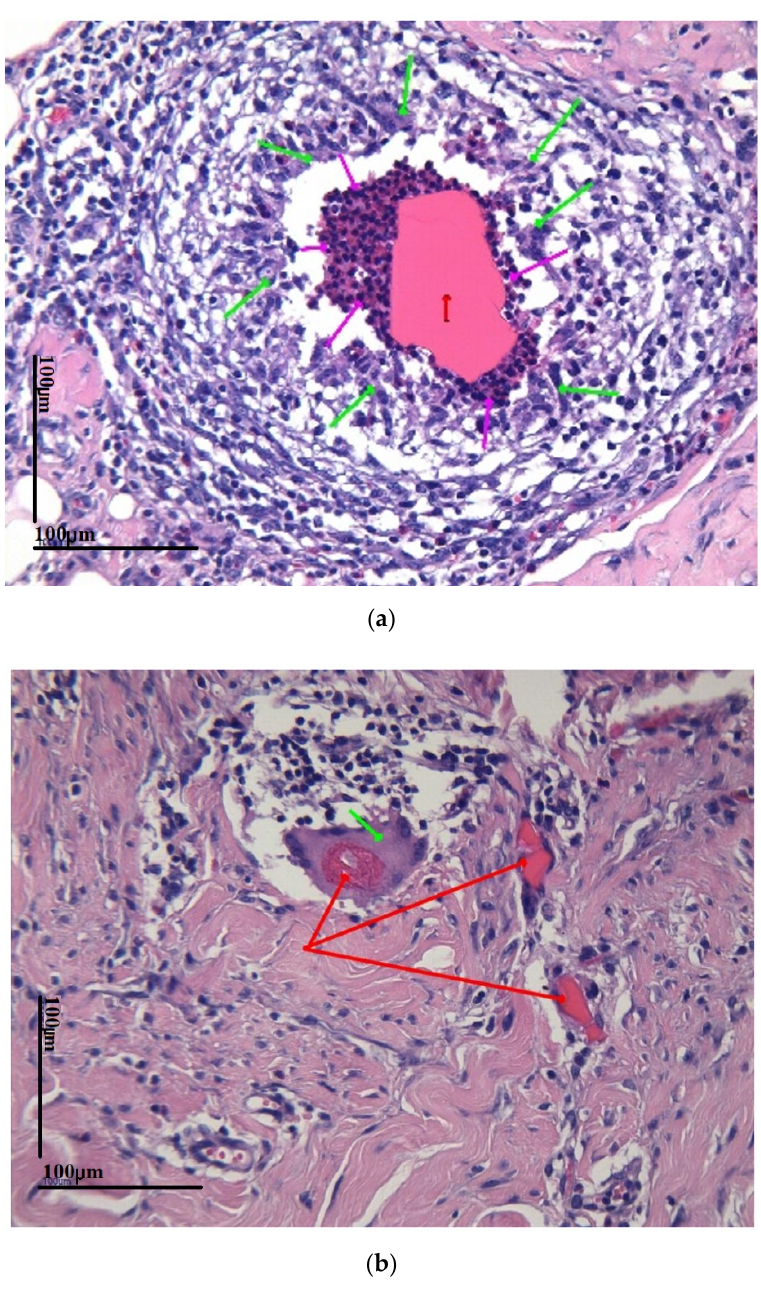
Figure 6. ( a ) HE staining, 20× magnification at 100 microns. Red arrows marks silicone. Green arrows mark macrophages. Purple arrows mark eosinophils; ( b ) HE stain 20× magnification at 100 microns. Green arrow marks a multinucleated foreign body giant cell trying to phagocytize the silicone (red arrow).